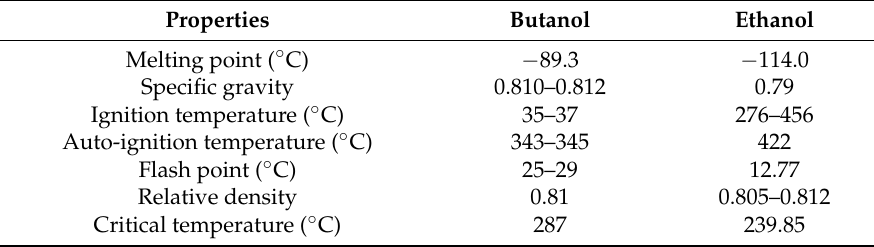
Table 6. Properties of biobutanol and bioethanol as vehicular fuel. Adapted from